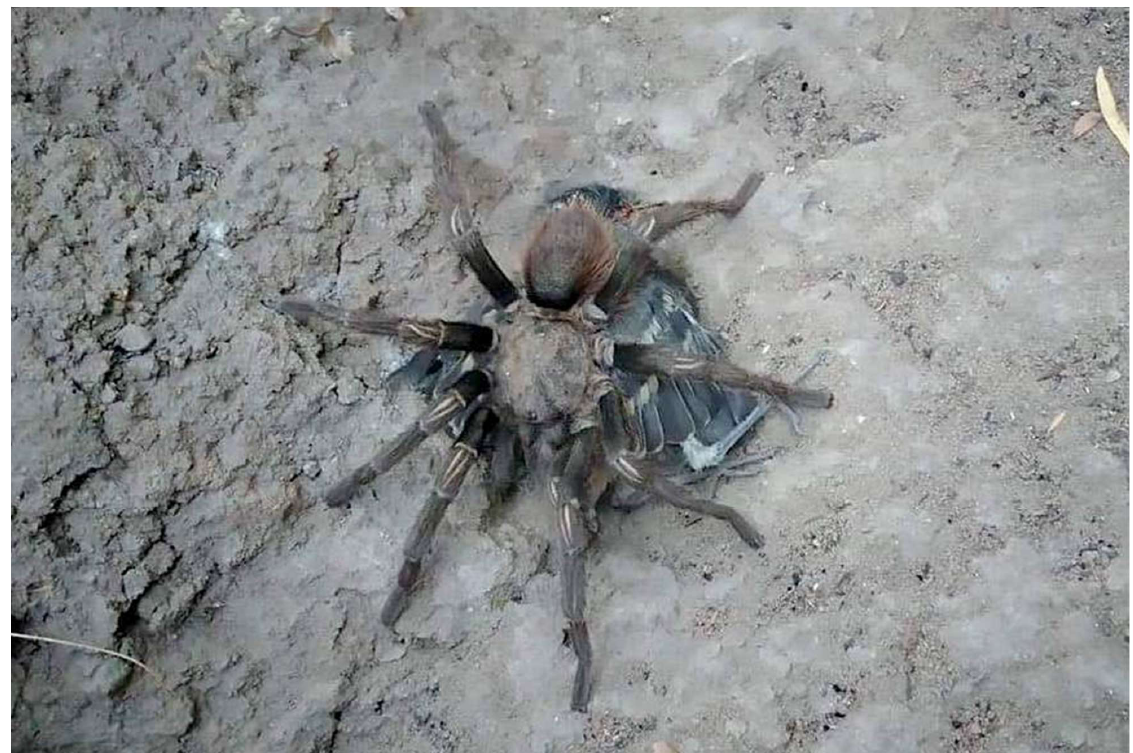
Figure 1. Euathlus sp. predating on a juvenile austral thrush ( T. falcklandii ). Cerro Viejo, Curacaví, Metropolitana region, Chile. Photo credit: Paula Cárdenas.